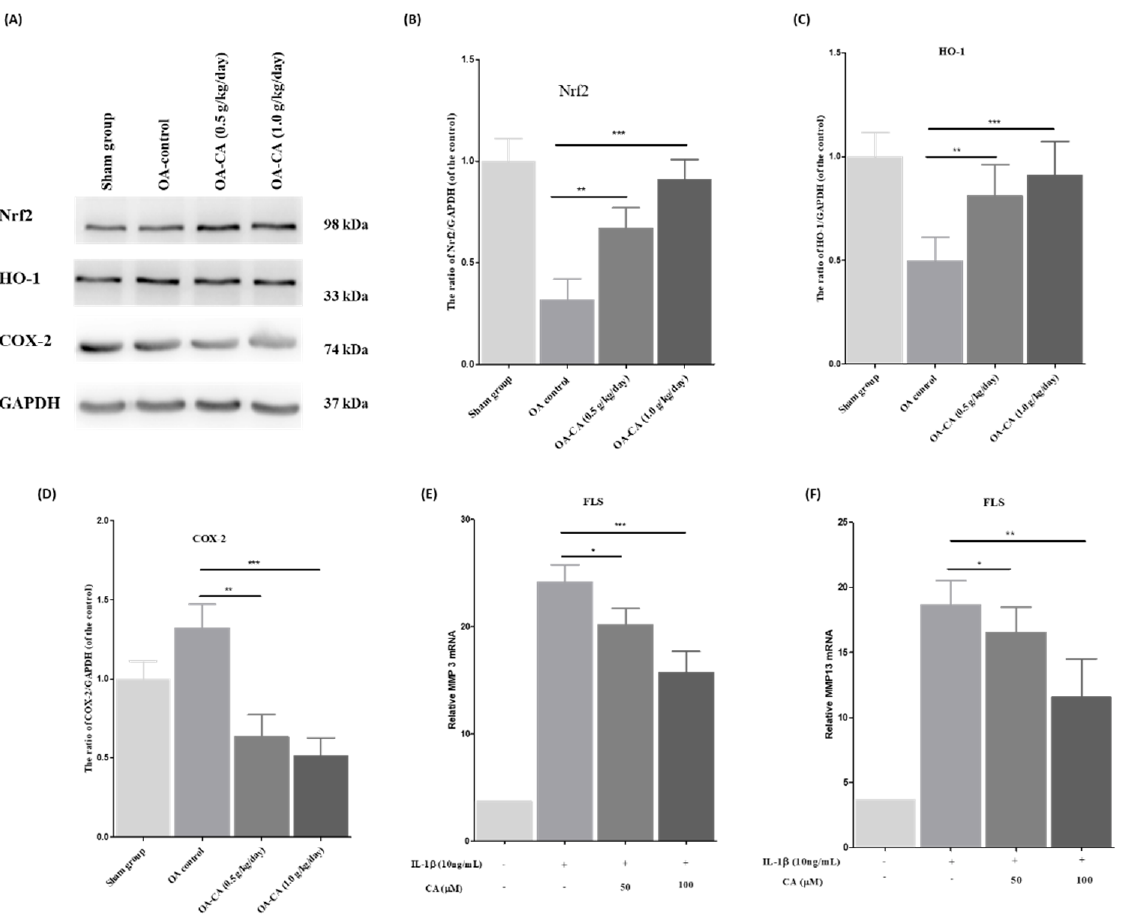
3.6. The Effect of CA on the Nrf2/HO-1 Signaling Pathway in ACLT + MMx-Induced OA Knee Rats, as Well as MMP-3 and MMP-13 mRNA Expression in FLS Cells Stimulated by IL-1 β The activation of the Nrf2 signaling pathway, and its consequences, were investigated through Western blot analysis of knee-tissue samples. As shown in Figure 8A, the Nrf2, and HO-1 protein levels were lower, and COX-2 protein levels were higher in the OA- control group animals compared to the sham group animals. CA treatment activates the Nrf2/HO-1 signaling pathway ( p < 0.001), while decreasing COX-2 protein expression levels ( p < 0.001). The quantification studies are shown in Figure 8B–D.